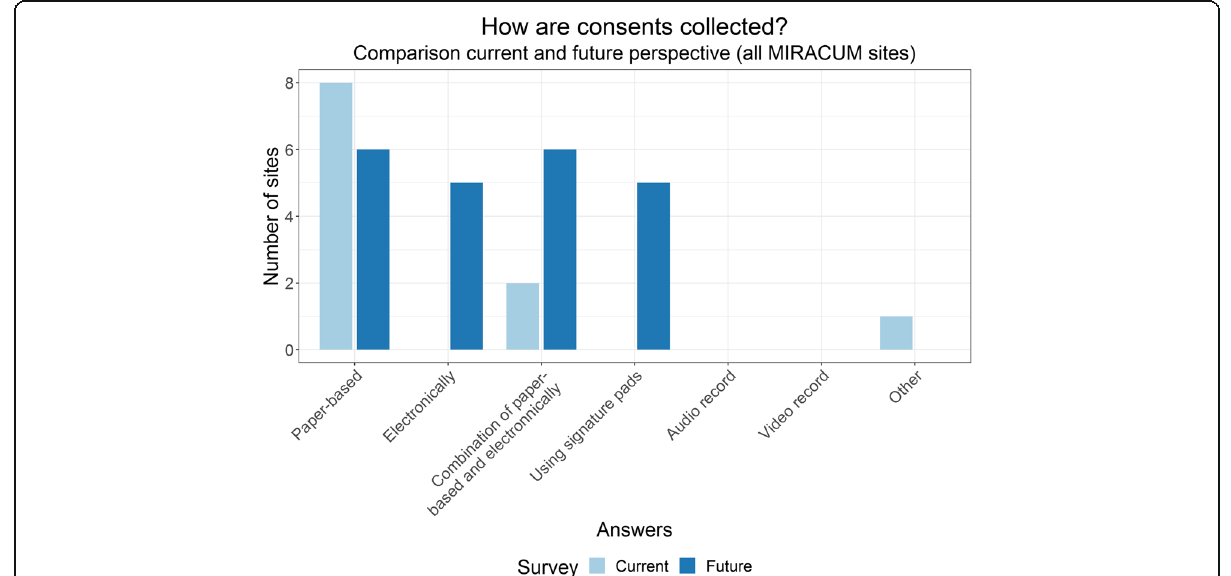
Fig. 4 How are consents collected?. Frequency distribution of how consents are collected currently and expected in the